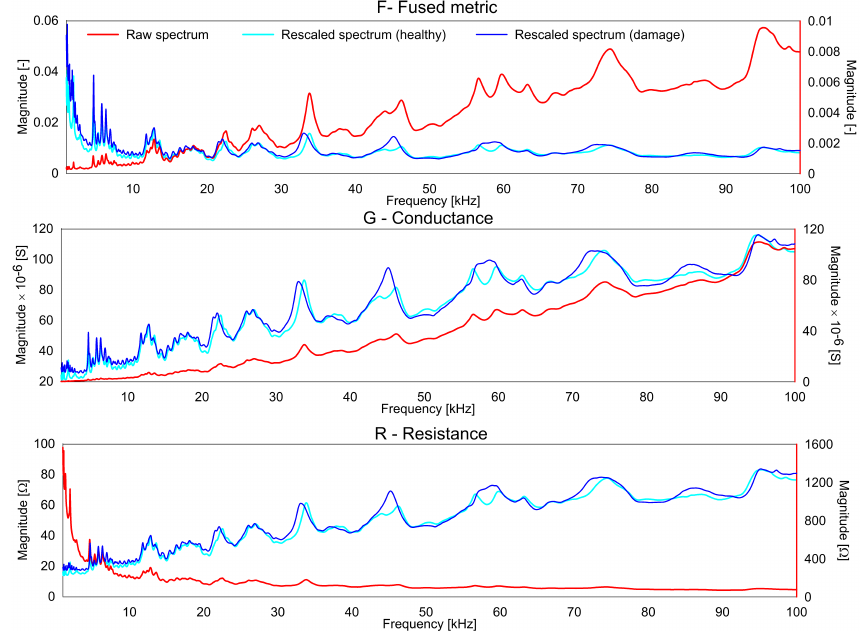
Figure 1. Raw and rescaled spectrum (healthy and damage scenario) for F, G,